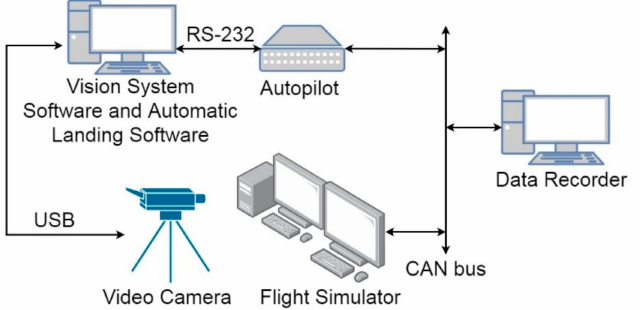
Figure 15. SIL rig configuration for testing picture processing and control algorithms. Adapted from